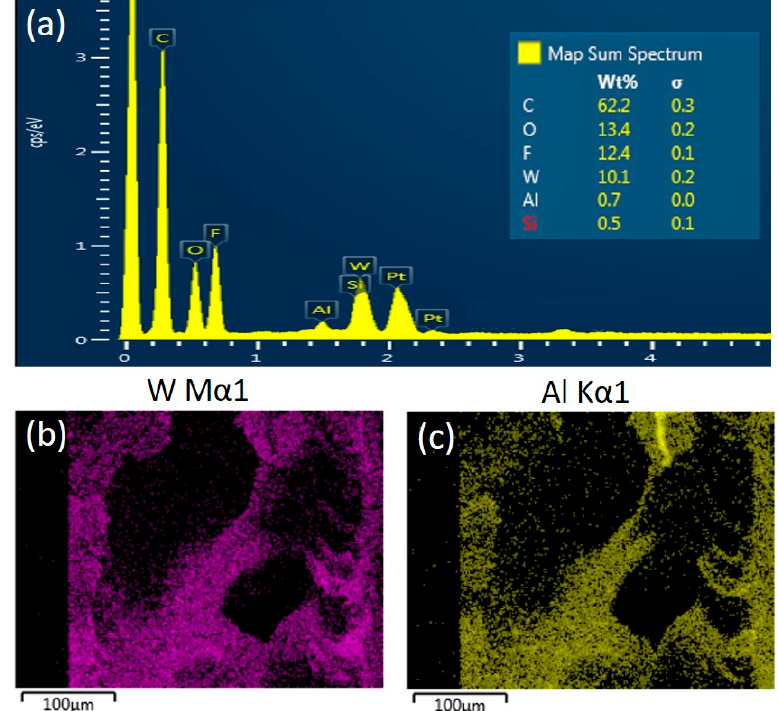
Figure 5. ( a ) Energy-dispersive X-ray spectroscopy (EDX) spectrum of the modified membranes (POMs-M) with inset of atomic contents of main elements and EDX images of ( b ) W and ( c ) Al elements of the cross-section of POMs-M membrane.